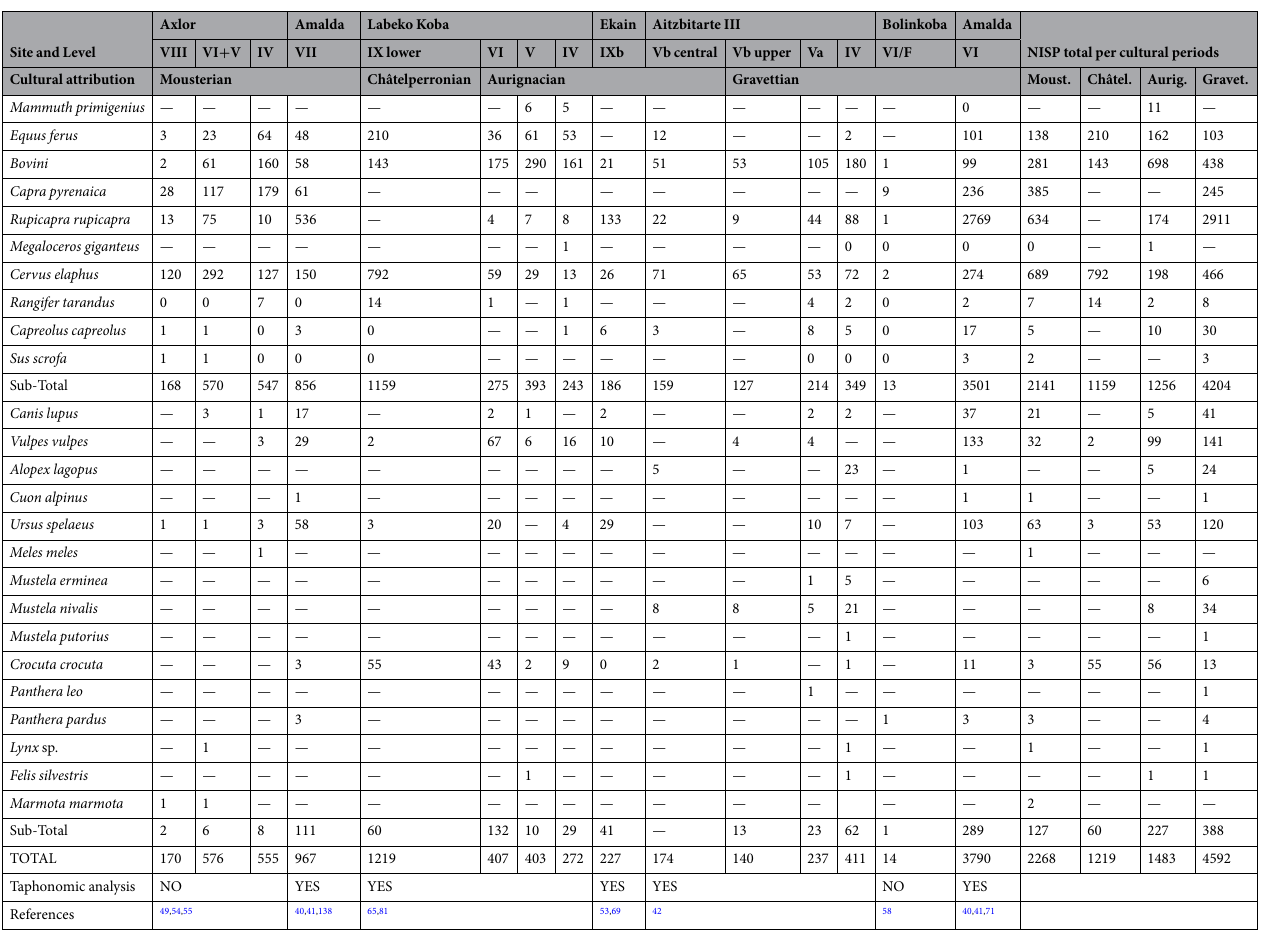
Table 3. Macromammal faunal assemblage NISP values represented in the levels of the archaeological sites sampled in this study, indicating when available references of taphonomic